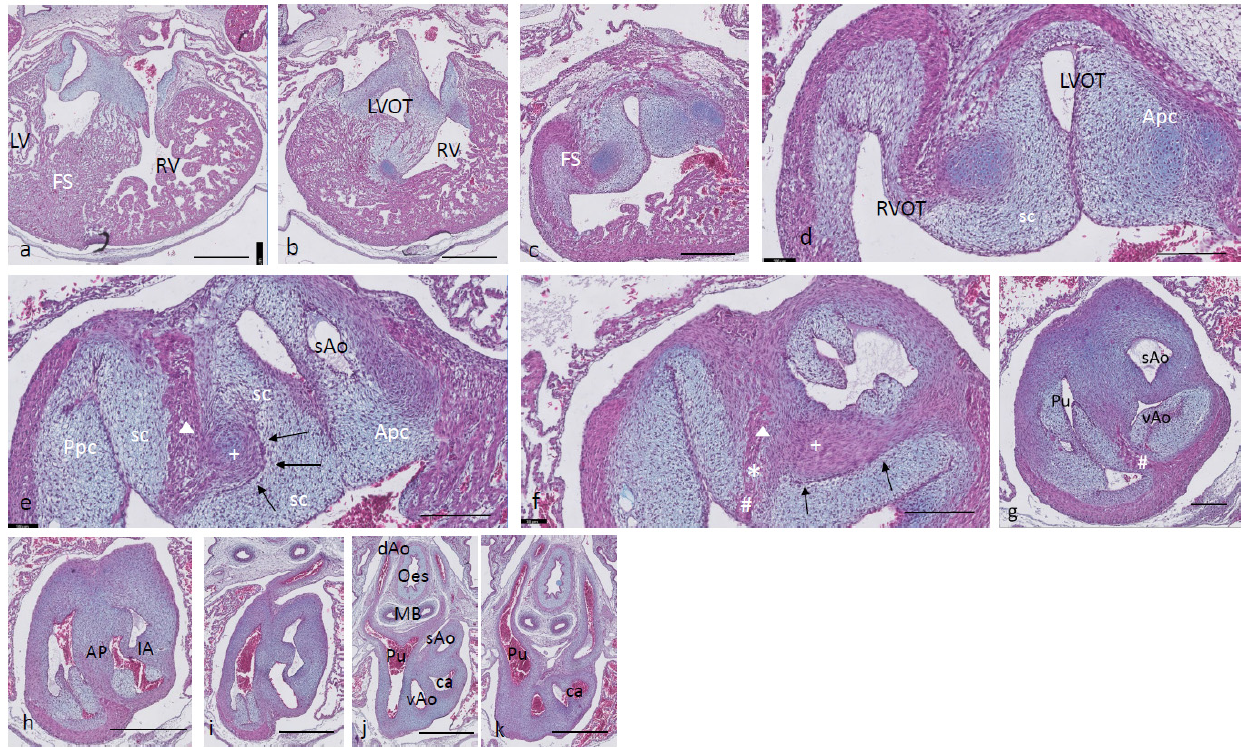
Figure 5. Ferguson stage 22, Figure ( a – i ), from AV canals to the arterial tree. Figure ( a , b ), septal cushion with cartilage between left and right ventricles. Figure ( c ), cartilage differentiation in both the septal and aortic parietal cushions. Figure ( d ), enlargement of Figure c, the septal cartilage related to the IA septum is located on the left aortic side of the folding septum. Figure ( e , f ), the AP (*), ( Δ ), (#) and the IA (+) septa are completely visible, containing their various elements. The tunnel of the foramen of Panizza is present (black arrows). Figure ( g – k ) demonstrate the branching pattern of the arterial tree. Key to the symbols # ventral myocardium, part of AP septum; * (presumably) left-sided neural crest cells, part of AP septum; + (presumably) right-sided neural crest, part of IA septum; Δ dorsal myocardium, part of AP septum. Magnification Figure ( a – c , h – k ), bar 500 µm; ( d – g ), 200 µm.